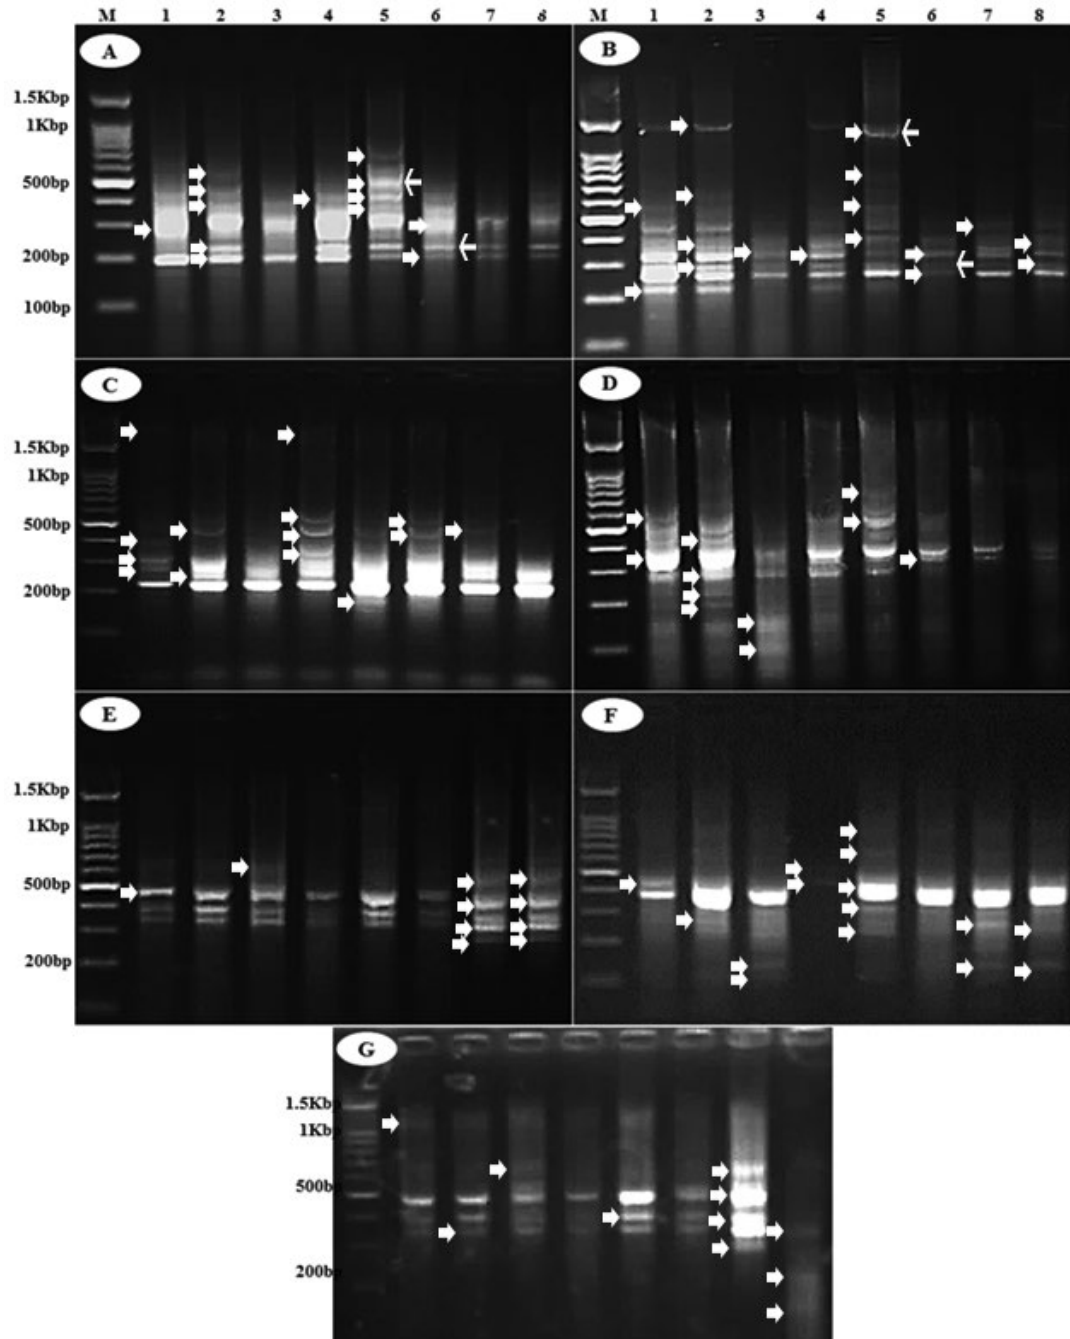
Figure 3. DNA fingerprinting from dd-PCR using different arbitrary primers; PR5F (A), PR5R (B), PR3F (C), PR3R (D), PPOF (E), PPOR (F), and PR1F (G) with reference to the affected bands (thick arrows) and the bands selected for sequenc - ing (thin arrows). M, 1.5 Kbp DNA marker; 1,untreated maize (control); 2,infected with R. solani ; 3,treated with khella extract 10%; 4,infected and treated with khella extract 10%; 5, treated with khella extract 15%; 6, infected and treated with khella extract 15%; 7, treated with khella extract 20%; and 8,infected and treated with khella extract